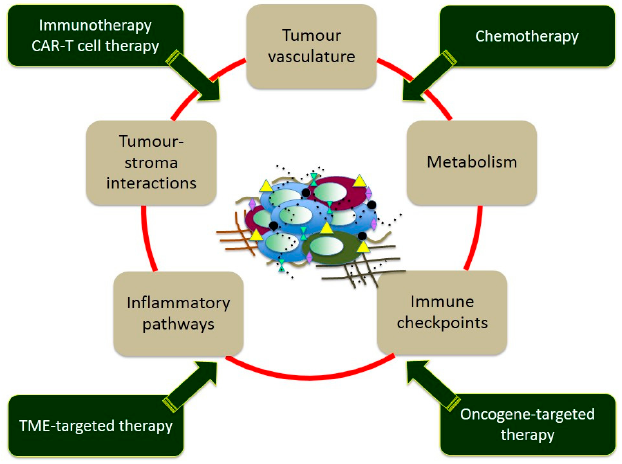
Figure 1. Graphical representation of the tumour/metastasis heterogeneity and of the main targets and therapeutic approaches (CAR-T = Chimeric Antigen Receptor T cell; TME = Tumour Micro Environment).